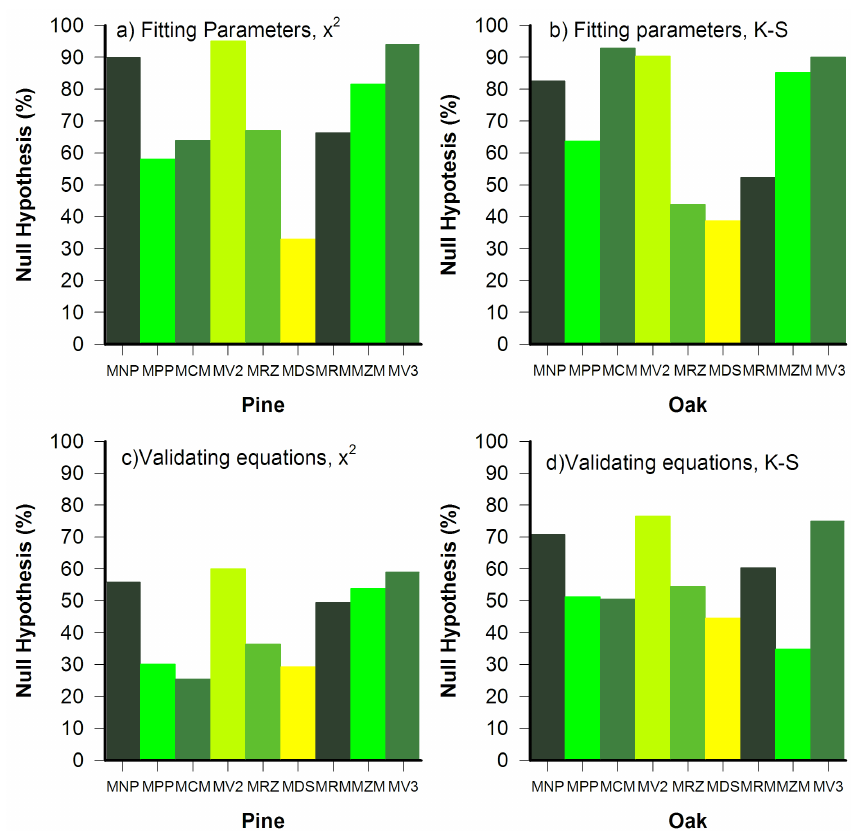
Figure 2. Goodness of fit tests χ 2 and K-S conducted on nine different techniques of parameter estimation of the Weibull density function for 587 forest stands of fitting ( a , b ) and 250 forest stands of validation ( c , d )